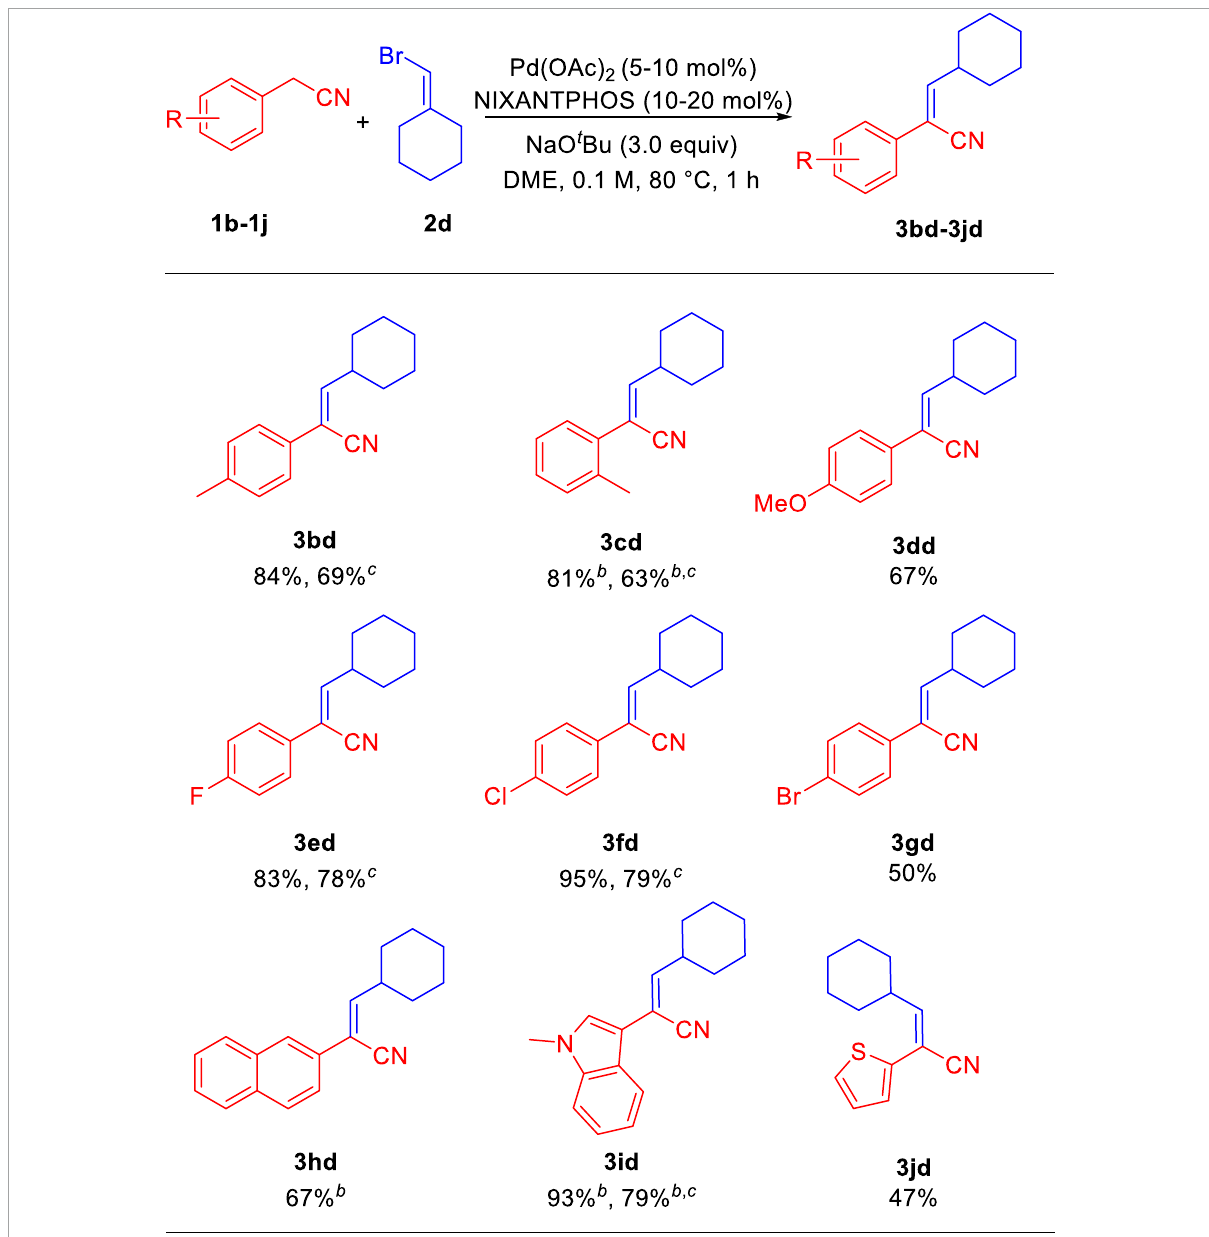
TABLE 3 Scope of arylacetonitriles a